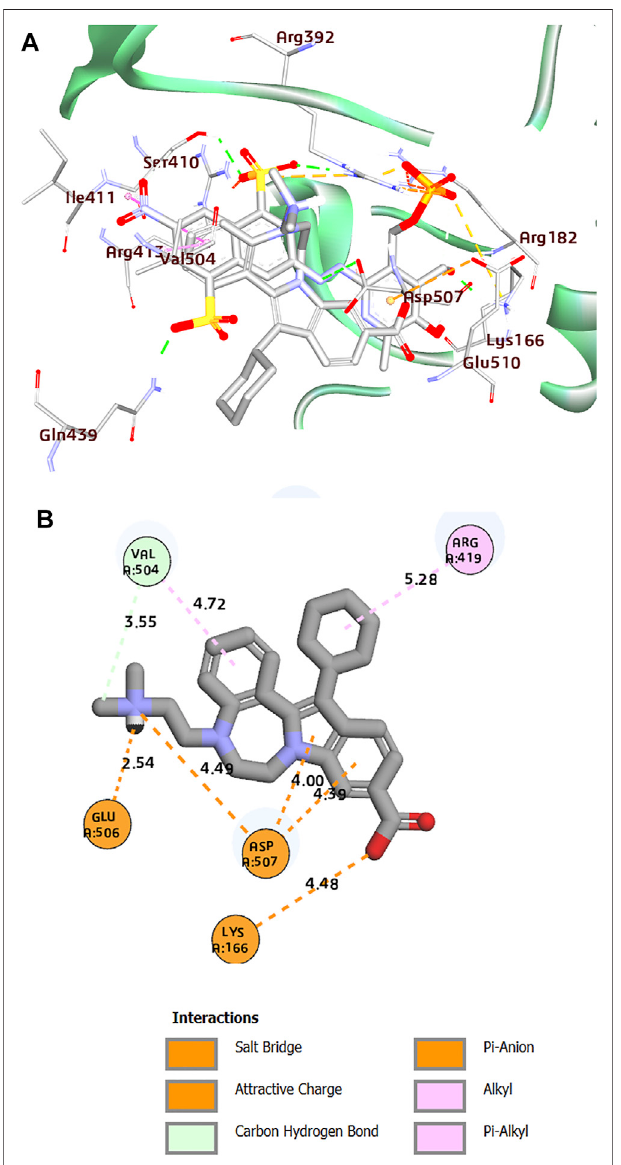
FIGURE 3 | (A) Superposition of co-crystal structures of PPNDS and CHEMBL1204385 along with their interactions in the binding site of HuNoV RdRp (PDB: 4LQ3). (B) 2D representation of the protein – ligand complex of CHEMBL1204385 including distances between the ligands and the interacting residues.